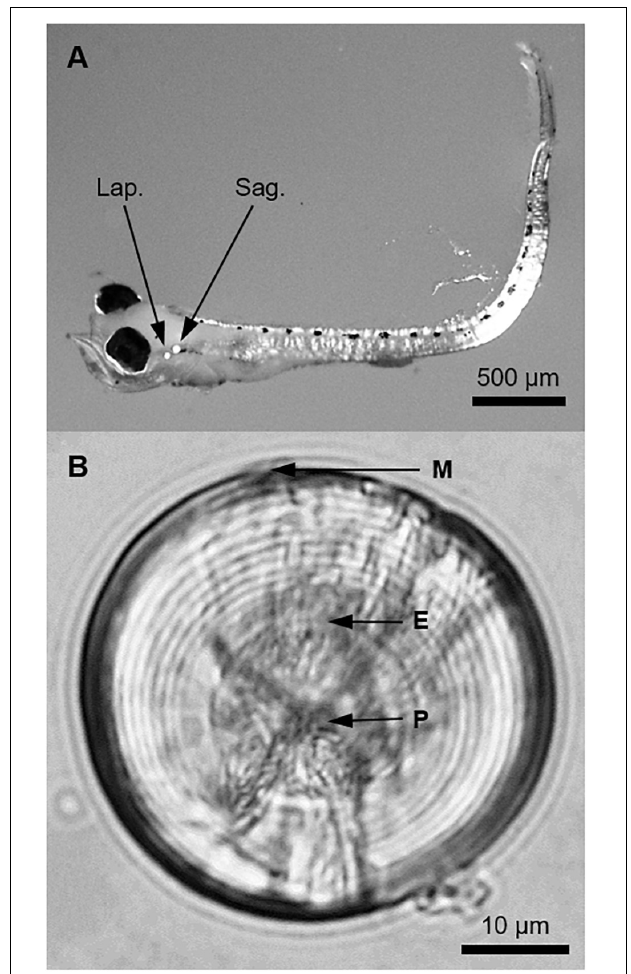
FIGURE 2 | (A) A pre-flexion larval King George whiting of 3.7 mm SL viewed at 20 × magnification under a dissecting microscope. Polarized light was used to illuminate the otoliths (Lap., lapillus; Sag., sagitta). (B) Whole sagittal otolith of a larval King George whiting viewed from the proximal surface (sulcus upward) at 1,000 × magnification using immersion oil (P, primordium; E, exogenous feeding check; M, posterior margin). Otolith diameter was 48.9 µ m and the larva was 18 days old and 4.7 mm